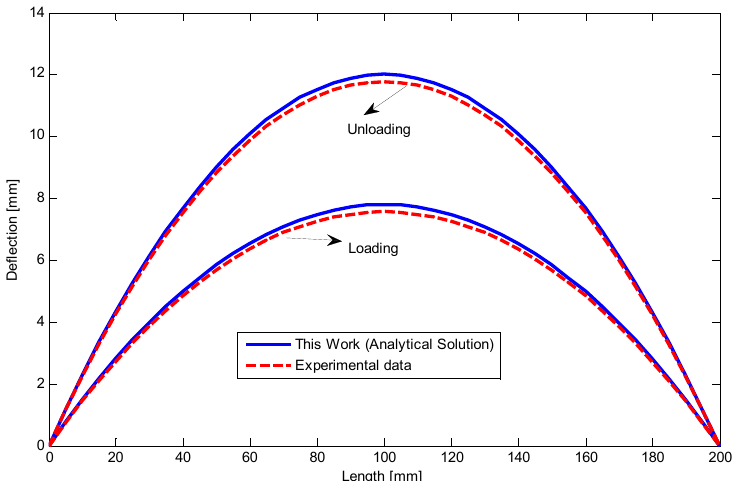
Figure 24. The relationship between deflection and length at the end of loading and unloading for the circular SMA beam under four-point bending test with the force of 17 kN.